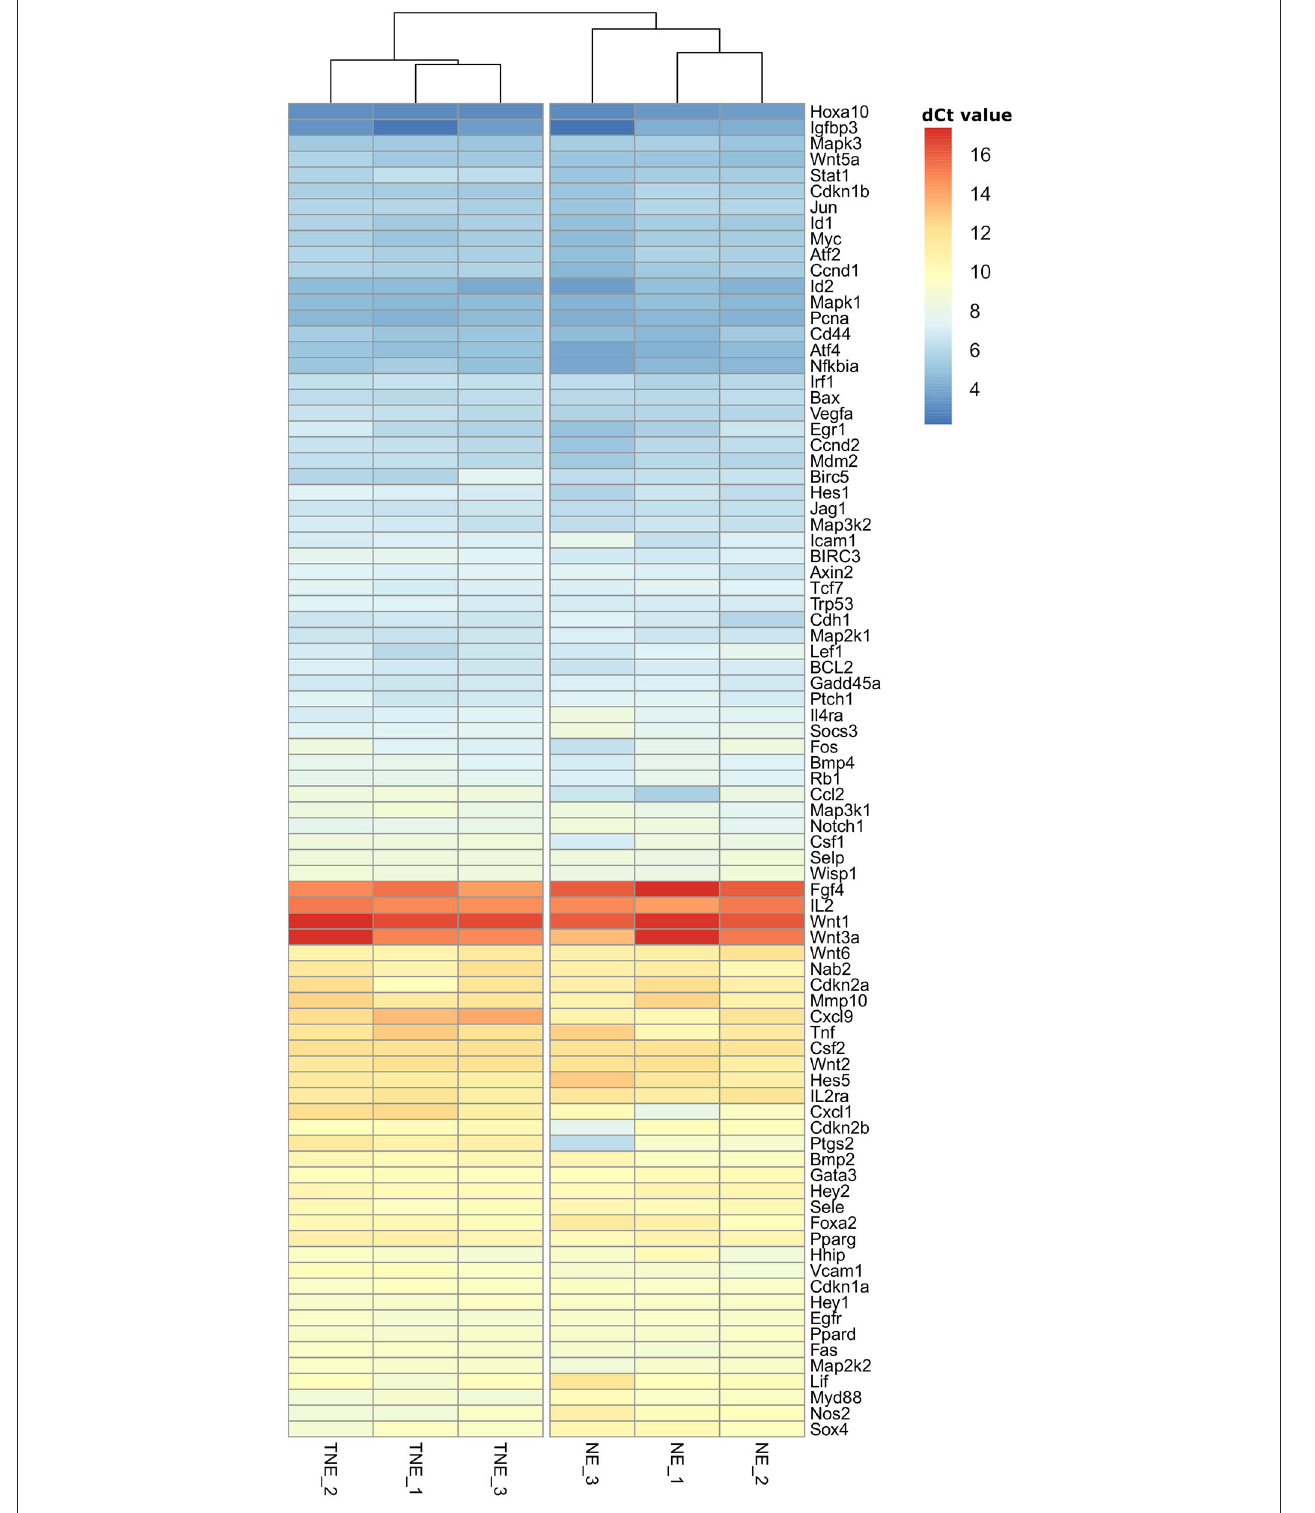
FIGURE 3 | Hierarchical clustering heatmap of mRNA transcripts of nine signal transduction pathways differentially expressed in recipients’ uteri of normal (NE) and TNF α - (TNE) treated embryos. Gene expression level is color coded.